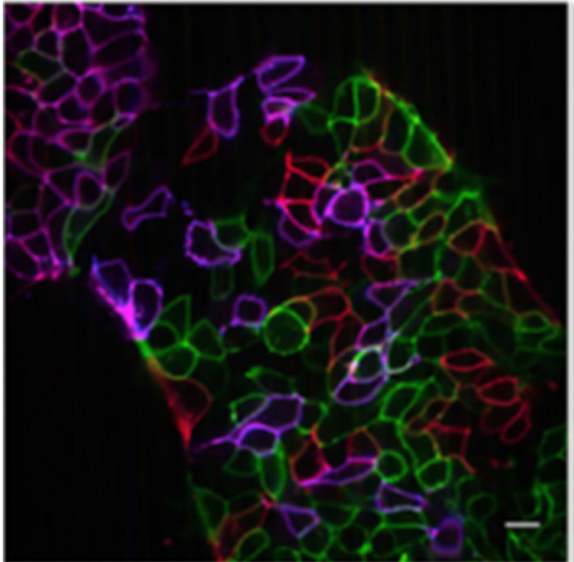
Figure 2. Live human-induced pluripotent stem cells after 12 h with transfected with eGFP, mOrange2 and mKate2. Scale bar = 20 µ m. Reproduced with permission [185]. Copyright 2020